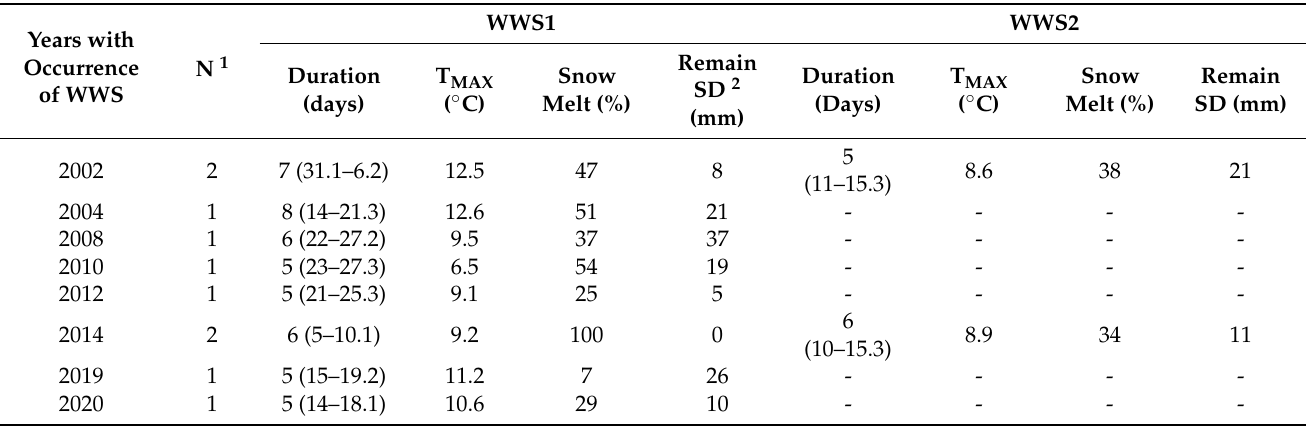
Table 5. The occurrence of discrete winter warm spells (WWS1, WWS2) in individual years observed during the studied period 2000–2020.